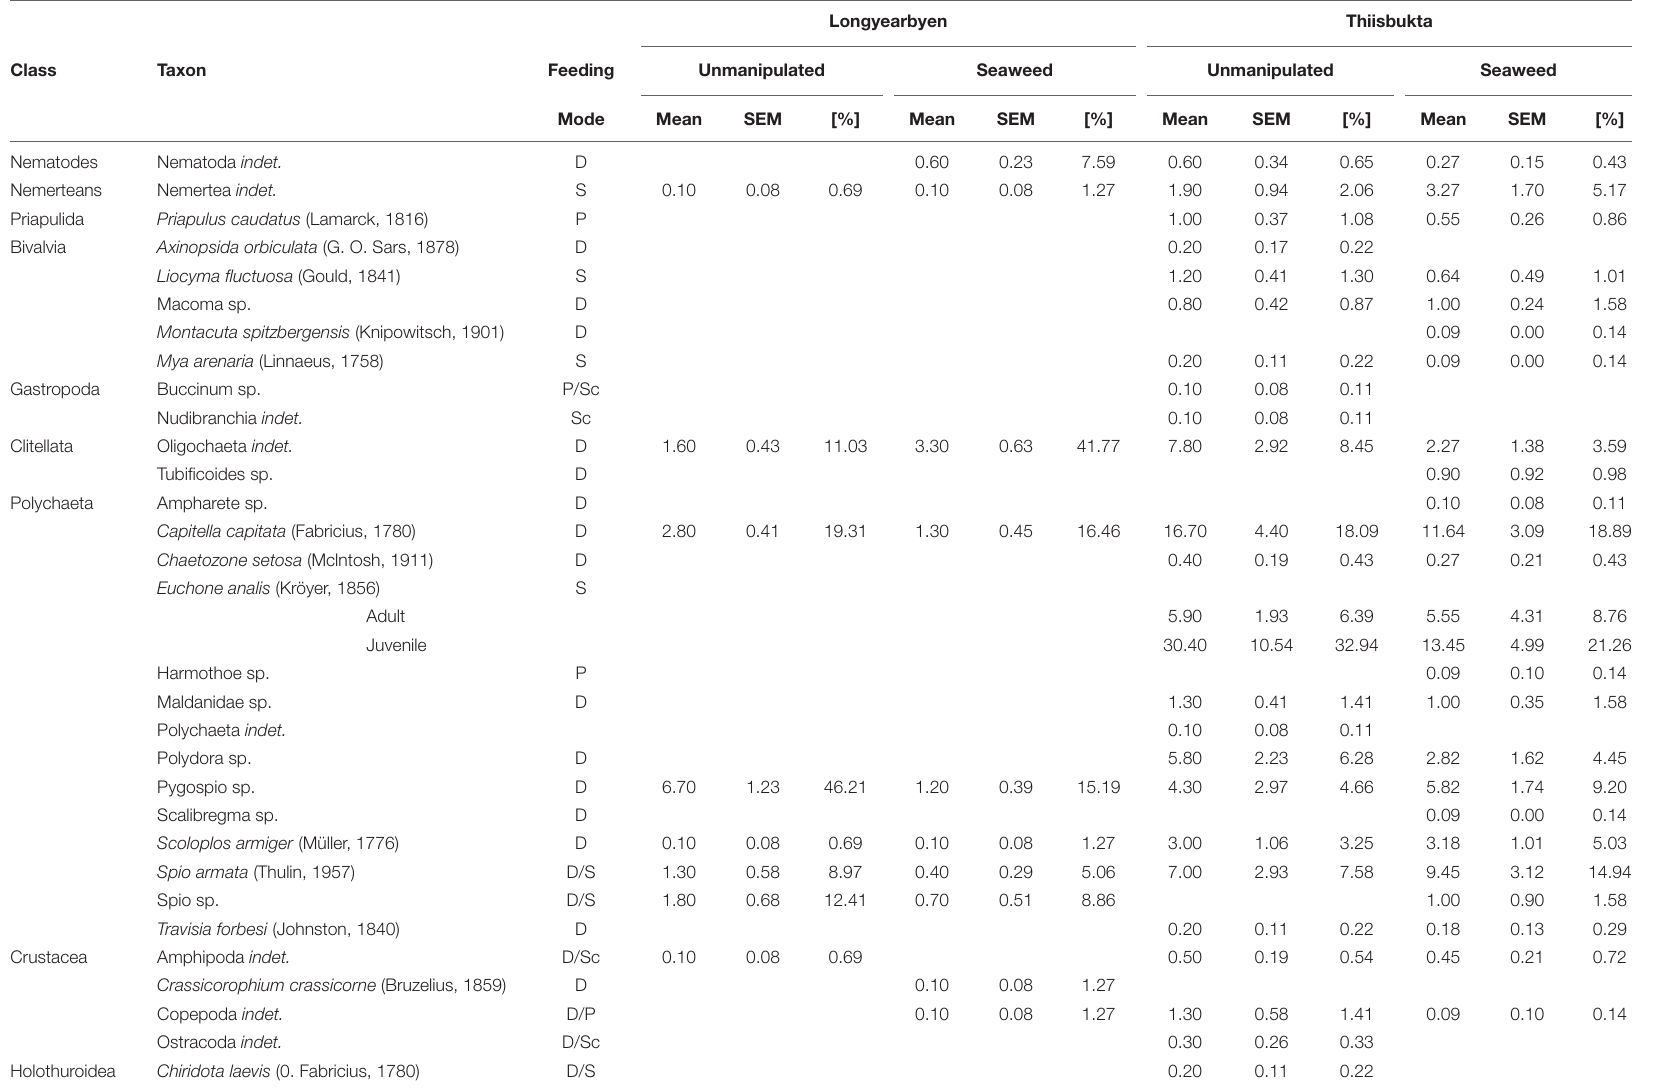
TABLE 1 | Mean and standard error of the mean (SEM) number of individuals of each taxon encountered in samples taken from plots covered with detached seaweeds and unmanipulated areas at the end of 83–81 days experiments in Longyearbyen and Thiisbukta,